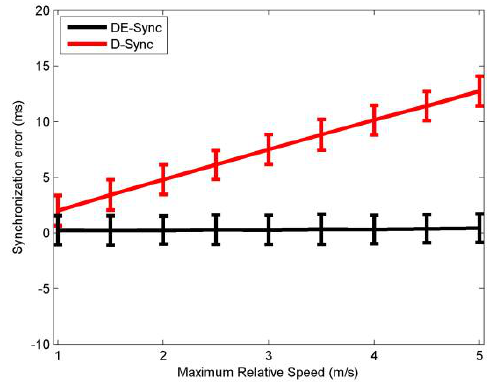
Figure 5. Performance with relative speed.